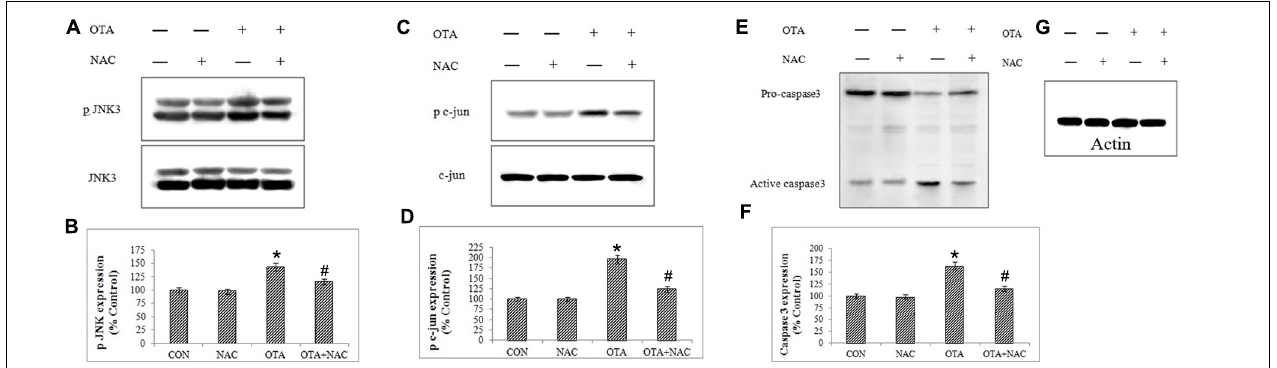
FIGURE 9 | Protein-expression profiles for apoptotic biomarkers (JNK3, c-jun and caspase3) were analyzed in Neuro-2a cells by immunoblotting (A,C,E,G). The band intensity is calculated by Image-J software (B,D,F) . The data represented as mean ± SEM of three independent experiments. ∗ p < 0.05 versus respective control group and # p < 0.05 versus respective OTA treated